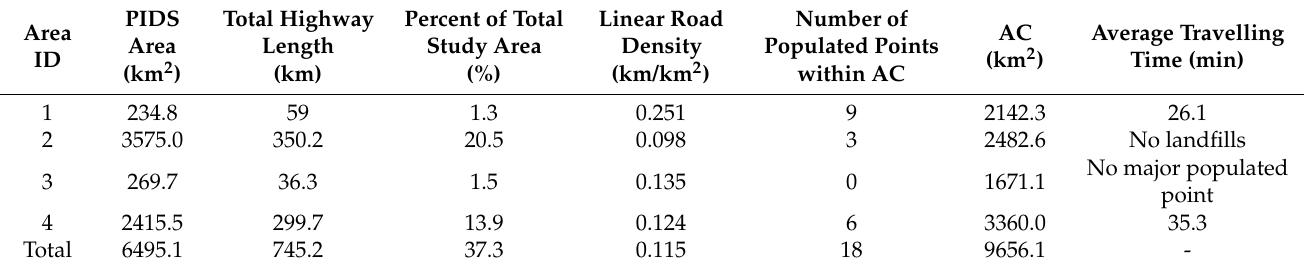
Table 4. Attributes of the identified PIDS in Division